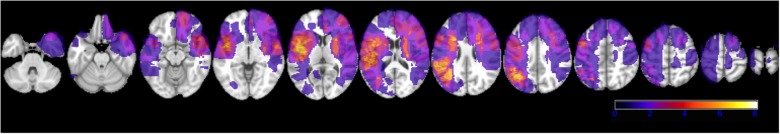
Overlay map depicting number of patients with damage in each voxel, presented in MNI space and following radiological convention (left side = right hemisphere).